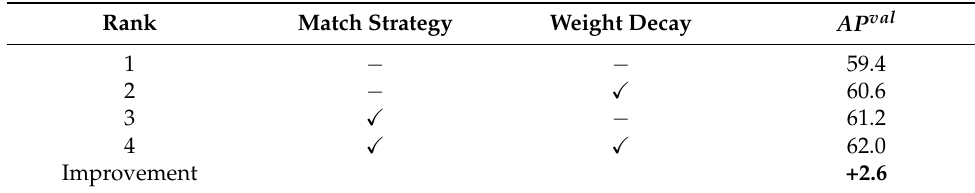
Table 8. Results of ablation experiments with improved strategies.